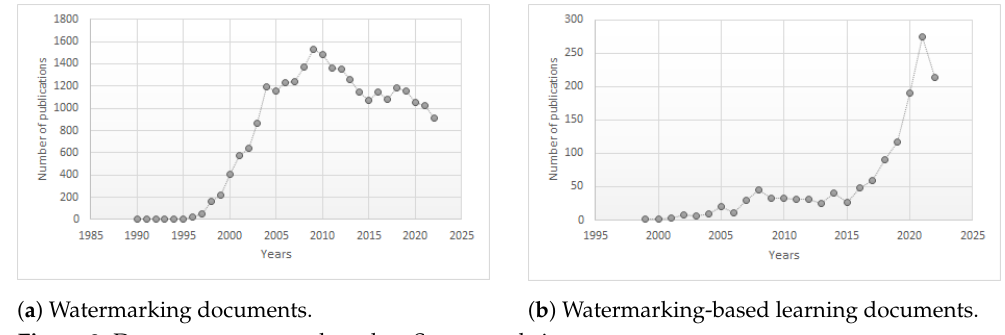
Figure 3. Documents per year based on Scopus